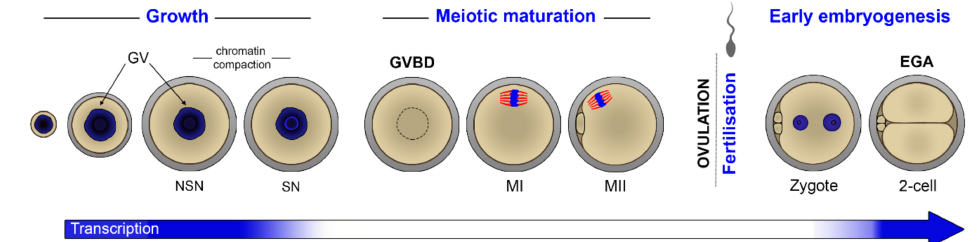
Figure 1. Oogenesis and early embryo development in mice. The blue colour in the arrow below indicates transcriptional activity. GV: Germinal vesicle, GVBD: Germinal vesicle breakdown, NSN: Non-surrounded nucleolus, SN: Surrounded nucleolus, MI: Metaphase I, MII: Metaphase II, EGA: Embryonic genome